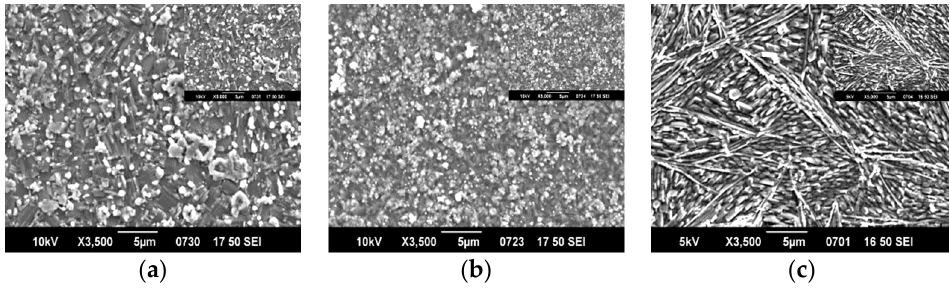
Figure 4. SEM images of the as ‐ grown vanadium oxide coatings by APCVD at 450 °C for gas precursor ratios of VCl 4 :H 2 O of ( a ) 1:1, ( b ) 1:5, and( c ) 1:7.